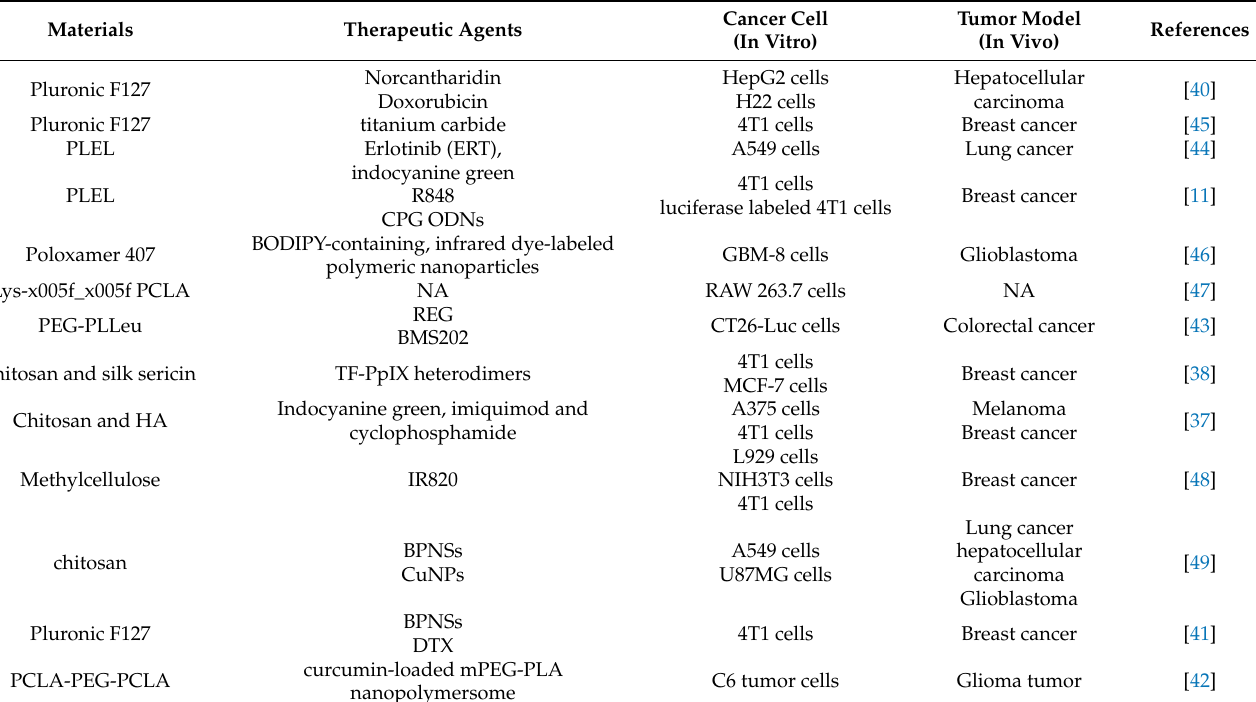
Table 1. Examples of thermosensitive hydrogels recently developed for localized cancer